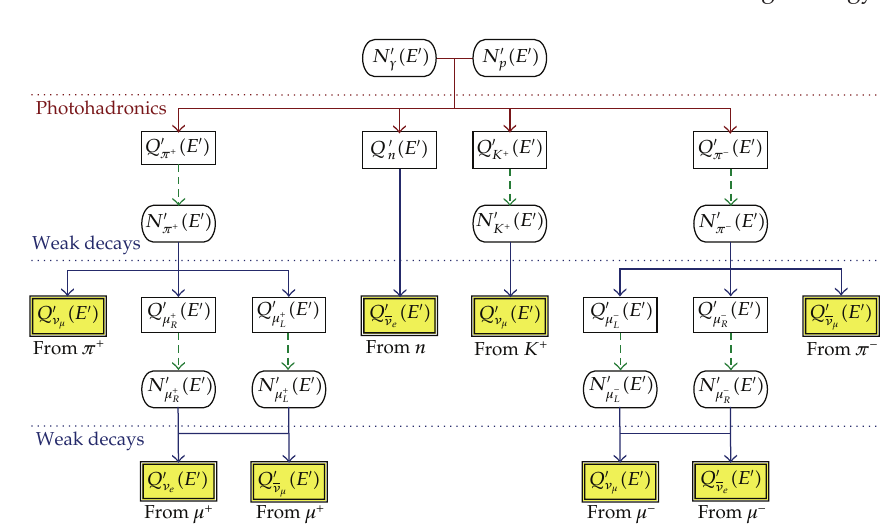
Figure 6: Flowchart describing the model (cid:3) in SRF (cid:4) . The functions Q (cid:3) (cid:3) E (cid:4) denote (cid:3) injection (cid:4) spectra per time frame (cid:5)(cid:3) GeVcm 3 s (cid:4) − 1 (cid:6) and N (cid:3) (cid:3) E (cid:4) steady spectra (cid:5)(cid:3) GeVcm 3 (cid:4) − 1 (cid:6) derived from the balance between injection and losses or escape. Dashed arrows stand for solving the steady state di ff erential equation (cid:3) 3.9 (cid:4) , figure taken from (cid:5) 30 (cid:6)